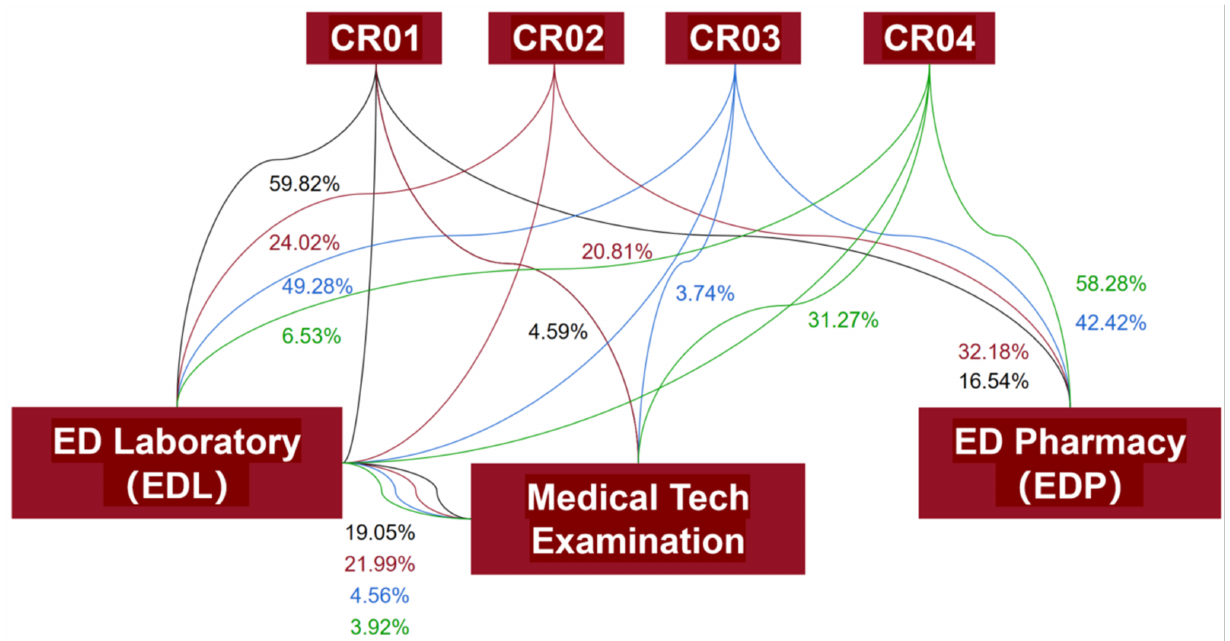
Figure 5. The second layer of